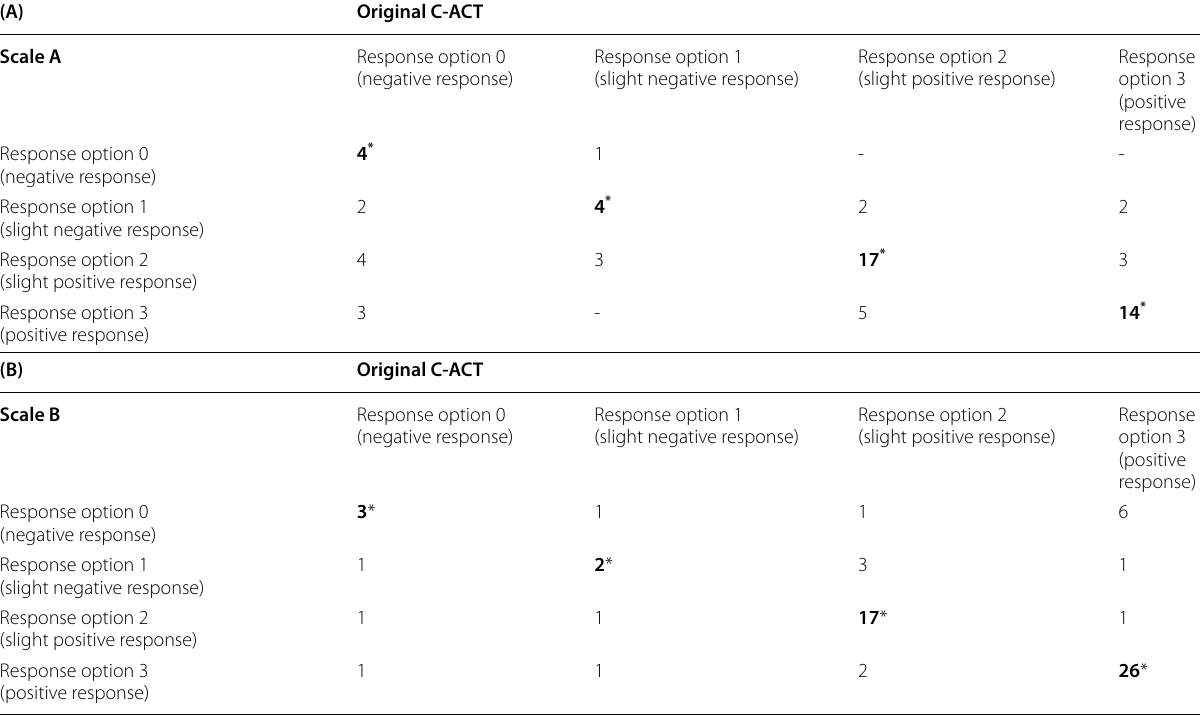
Table 2 Equivalency of combined responses across C‑ACT items 1–4, for the comparison of response option image selection